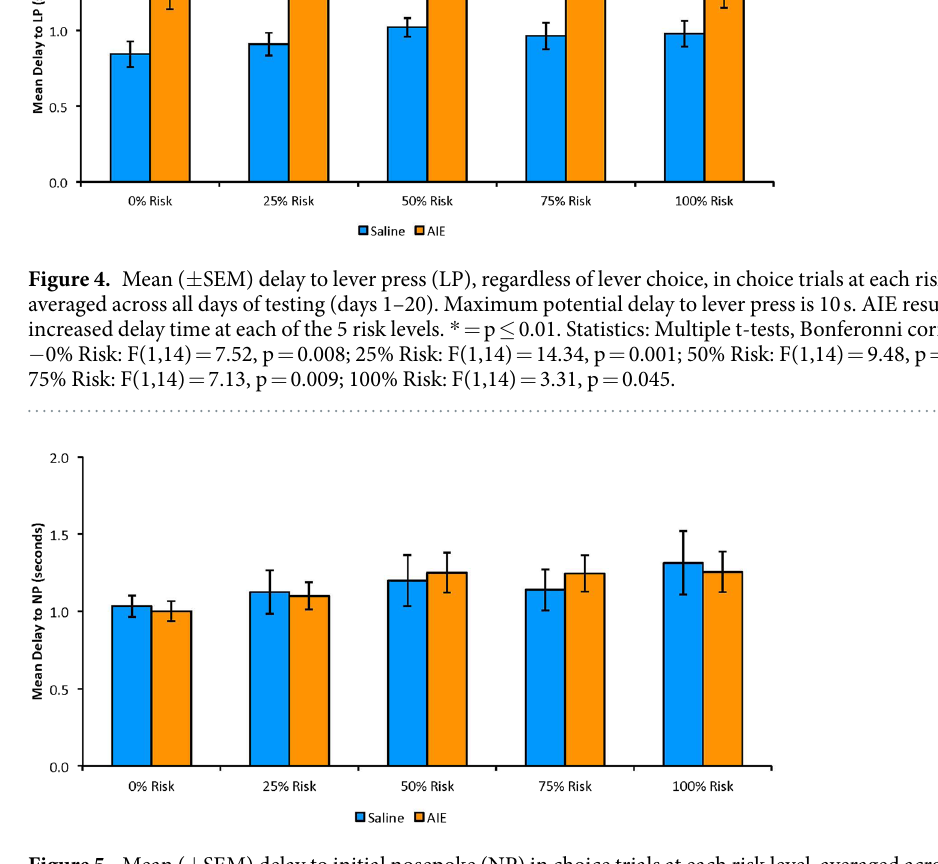
Latency to Lever Press. AIE markedly increased the latency to lever press across choice trials, regardless of the choice made, F(5,10) = 2.79, p = 0.04 (Fig. 4). Follow-up univariate tests reveal significant AIE-induced increases in response time at each risk level [0%: F(1,14) = 7.52, p = 0.008; 25%: F(1,14) = 14.34, p = 0.001; 50%: F(1,14) = 9.48, p = 0.004; 75%: F(1,14) = 7.13, p = 0.009; 100%: F(1,14) = 3.31, p = 0.045]. However, these results were not found in no-choice trials, F(5,10) = 1.74, p = 0.21. There was no difference between treatment groups in the latency to risky lever press (choice trials: [0%: t(14) = − 1.77, p = 0.05; 25%: t(14) = − 0.36, p = 0.37; 50%: t(12) = − 1.02, p = 0.16; 75%: t(10) = − 1.67, p = 0.07; 100%: t(7) = − 0.42, p = 0.35]; no-choice trials: F(5,10) = 0.68, p = 0.65). There was also no difference between treatment groups found in the latency to safe lever press (choice: F(5,10) = 2.50, p = 0.102; no-choice: F(5,10) = 1.22, p = 0.37). Latency to Initial Nosepoke. Although AIE increased the latency to lever press, it did not alter the latency to initial nosepoke, (choice trials: F(5,10) = 1.29, p = 0.17, Fig. 5; no-choice trials: F(5,10) = 0.18, p = 0.97), sug- gesting that there was no difference in general behavioral response time between AIE and control animals. Hot Plate Test.